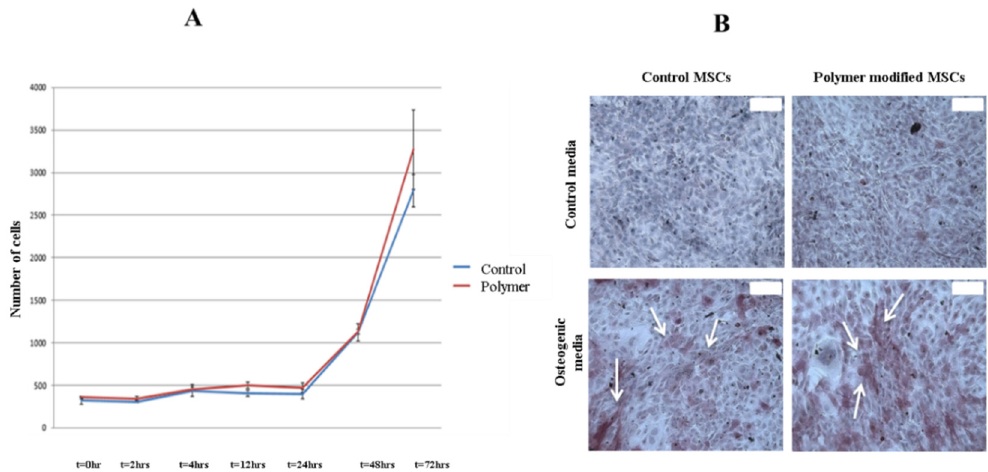
Figure 3. Effect of the polymer on the MSCs’ viability and osteogenic differentiation. ( A ) Cell viability assay ( p = 0.383, one-way ANOVA); ( B ) the differentiation was performed for 3 weeks with Osteo Pro Differentiation Kit and assessed for early osteogenic activity with alkaline phosphatase (ALP) assay. Dense pink color is a marker for osteogenesis (areas shown with white arrows), 10× (calibration = 100 µm). The alkaline phosphatase staining of coated and uncoated MSCs incubated in PBS or osteogenic areas of increased alkaline phosphatase activity, a dark pink color is produced (white arrows). As